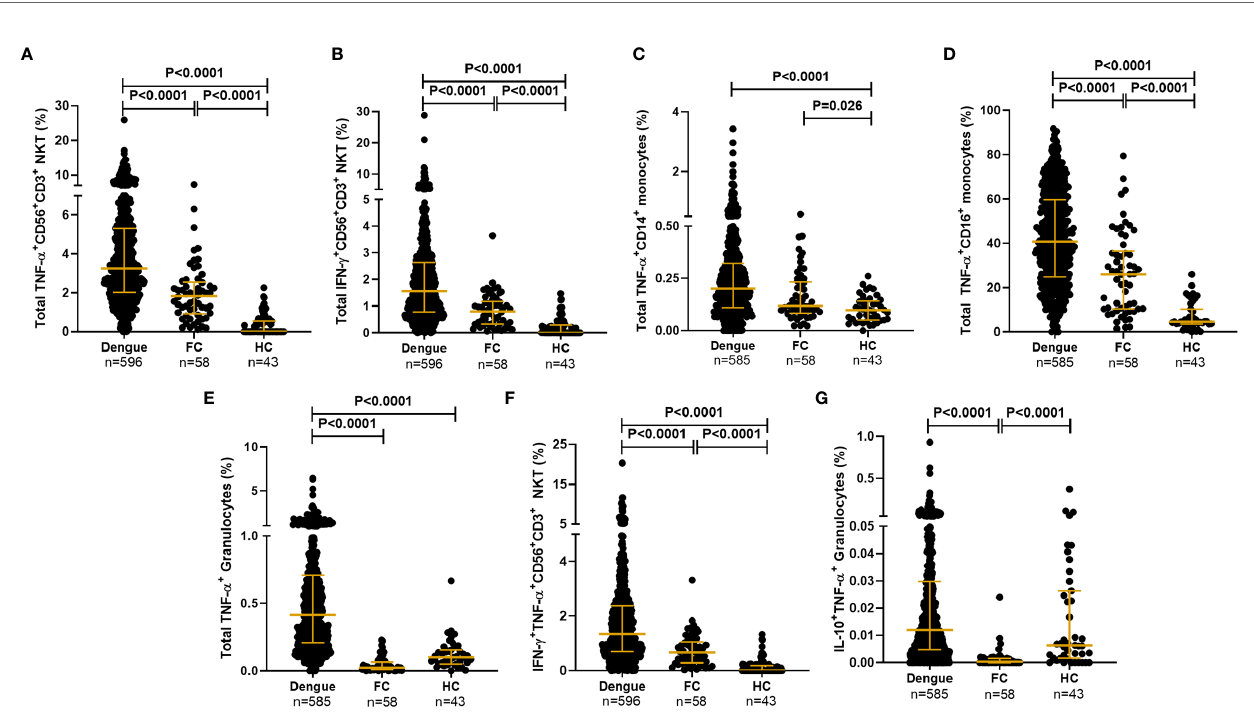
FIGURE 4 | DENV activated cytokine secretion from innate immune cells. Frequency of total (A) TNF- a + CD56 + CD3 + NKT cells, (B) IFN- g + CD56 + CD3 + NKT cells, (C) TNF- a + CD14 + monocytes, (D) TNF- a + CD16 + monocytes, (E) TNF- a + granulocytes, (F) IFN- g + TNF- a + CD56 + CD3 + NKT cells and (G) IL-10 + TNF- a + granulocytes from dengue patients compared to febrile controls (FC) and healthy controls (HC). Each dot represents one subject. P-value determined using Kruskal – Wallis test, followed by Bonferroni correction for multiple comparisons with median and IQR